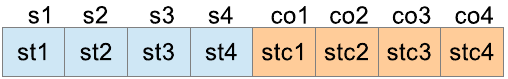
Figure 7. Solution representation of